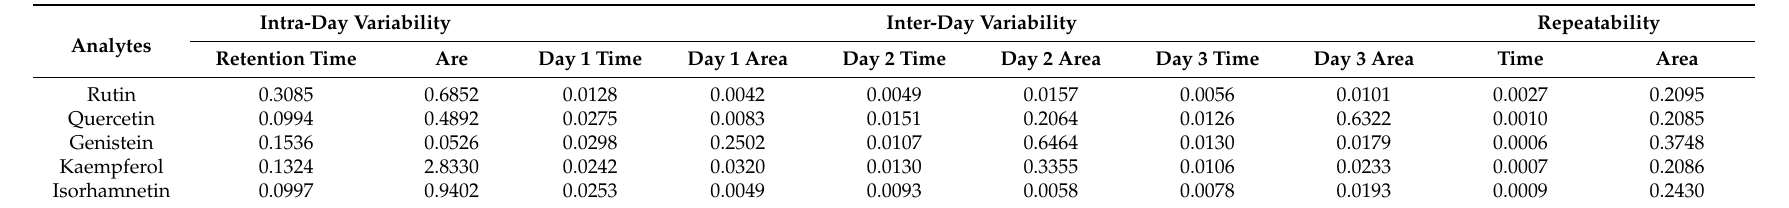
Table 7. Intra- and inter-day precision of constituents; results are shown as RSD % ( n = 6).